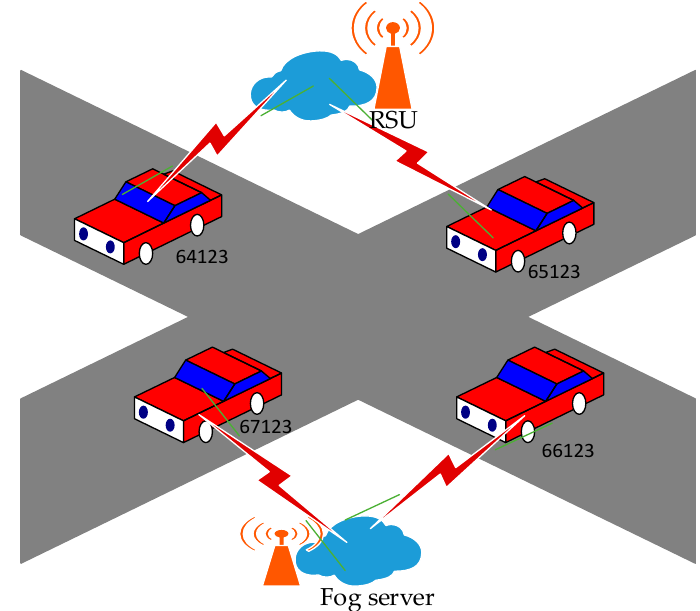
Figure 5 . VANET ( vehicular ad hoc network) structure with Integrated Fog Server Model. Figure 5. VANET (vehicular ad hoc network) structure with Integrated Fog Server